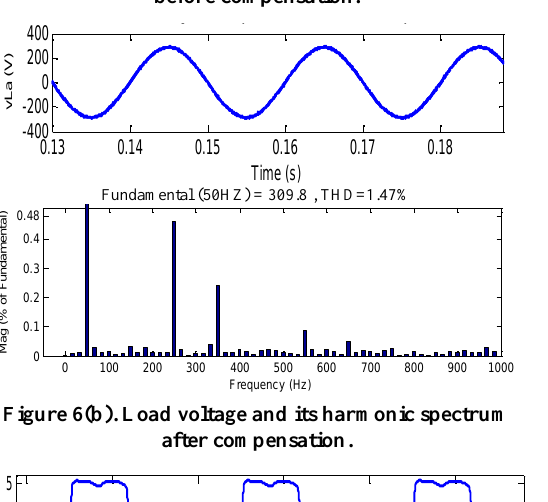
Figure 6(a). Load voltage and its harmonic spectrum before compensation.